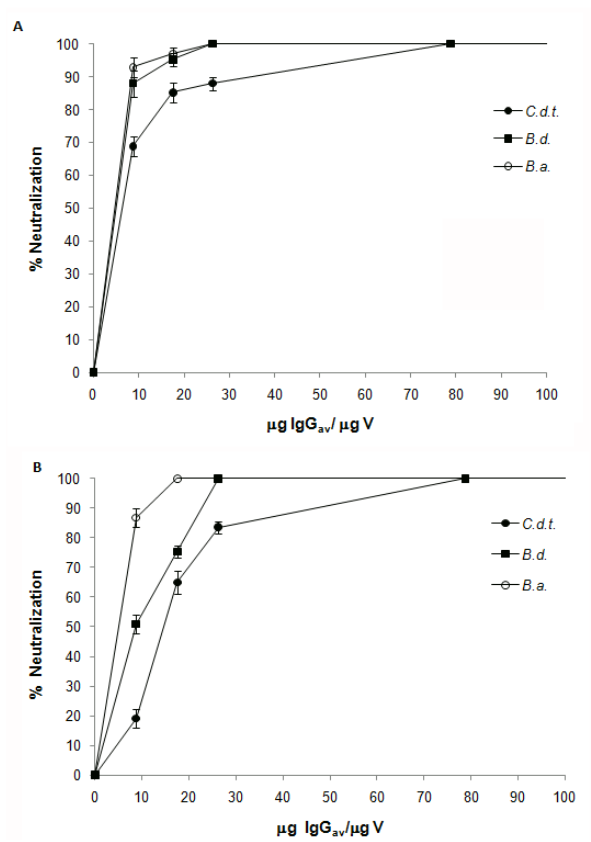
Figure 2. Neutralization of coagulant activity of bothropic and crotalic venoms by bothropic antivenom. ( A ) Micrograms of IgG of venom for the neutralization of fibrinogen coagulant activity. ( B ) Micrograms of IgG microgram of venom required to neutralize plasma coagulant activity. Results are presented as mean ± S.D. (n = 4). C.d.t .: Crotalus durissus terrificus ; B.a .: Bothrops alternates ; B.d. : Bothrops diporus ; V: venom.